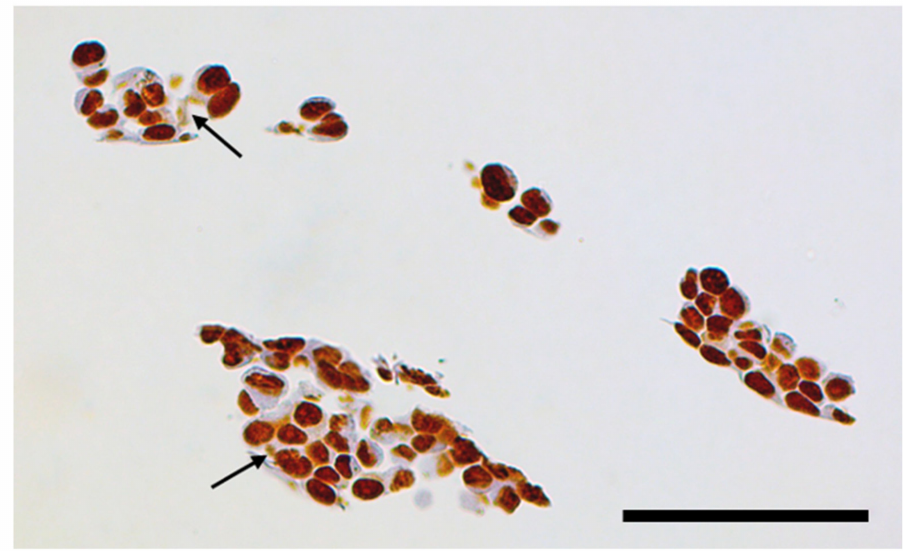
Figure 7. Immunohistochemistry for BIRC5 shows typically stained cell nuclei (for a control tissue sample see Figure S2). However, in addition to cell nuclei, some lightly stained material is also noticeable in the cytosol of many cells (e.g., areas indicated by arrows), possibly containing aggregates of nanocomposites with BIRC5 attached to particle surface in a manner permitting its recognition by the antibodies. Black bar corresponds to 100